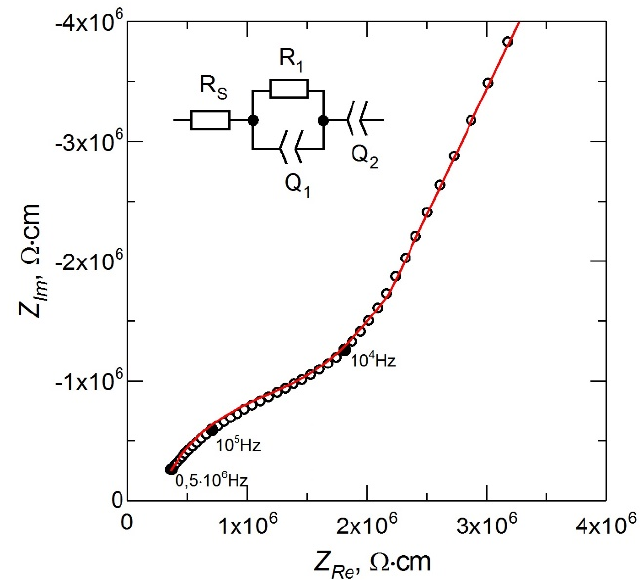
Figure 3. Nyquist plot of LiPON thin film.